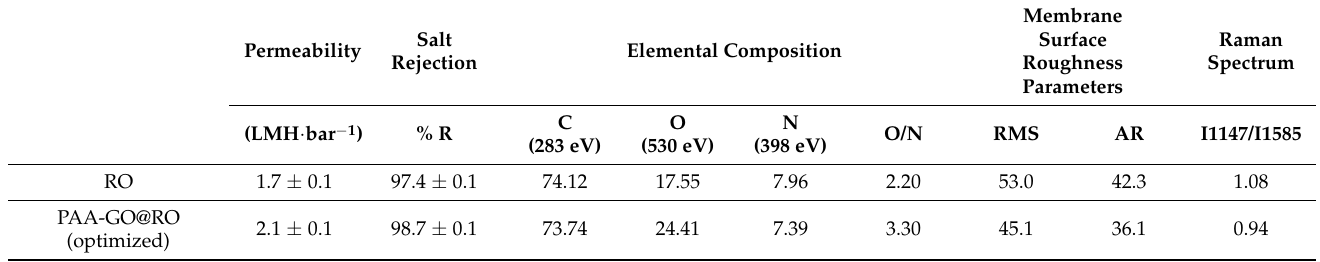
Table 9. Comparison of membrane permeation properties, and surface characterization (XPS, AFM, Raman) before and after